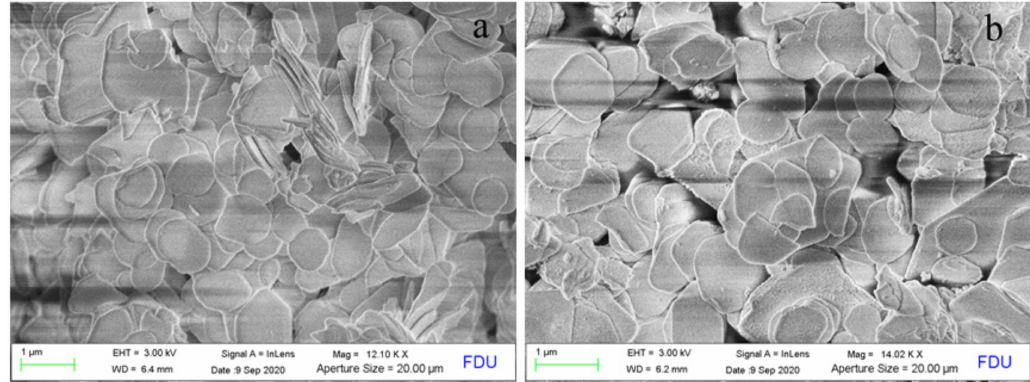
Figure 5. SEM images of Ho 2 O 3 -NS ( a ) and 0.04Sr-Ho 2 O 3 -NS ( b ).